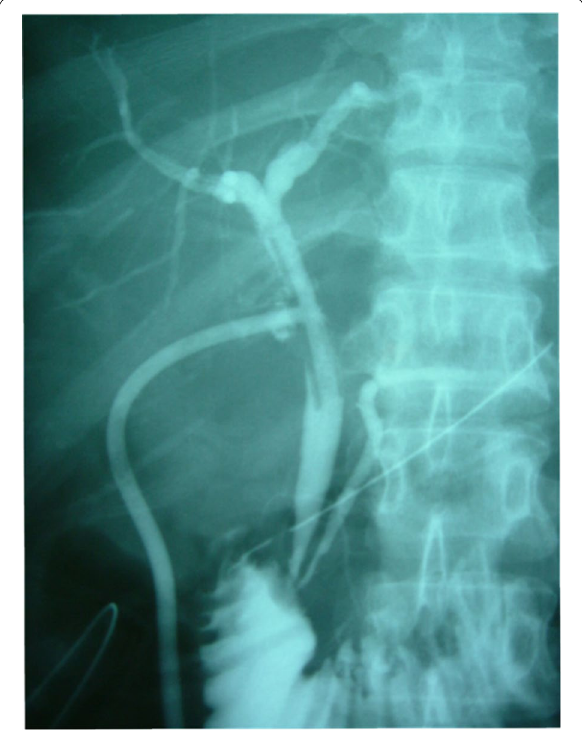
Fig. 5 Intra-operative cholangiography. Intra-operative cholangiography revealed no residual stones or abnormalities of the biliary sphincter